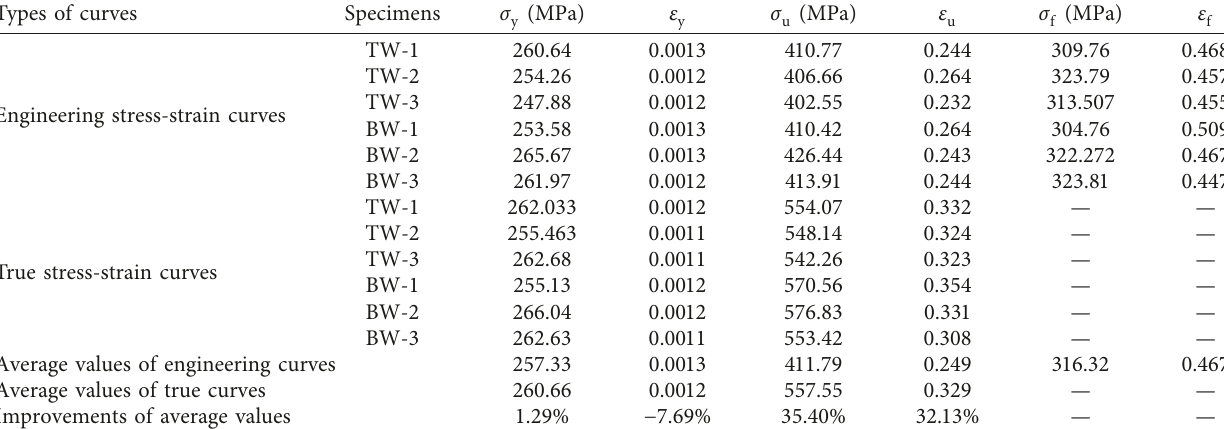
Table 2: Mechanical parameters of engineering and true stress-strain curves of flat coupons.